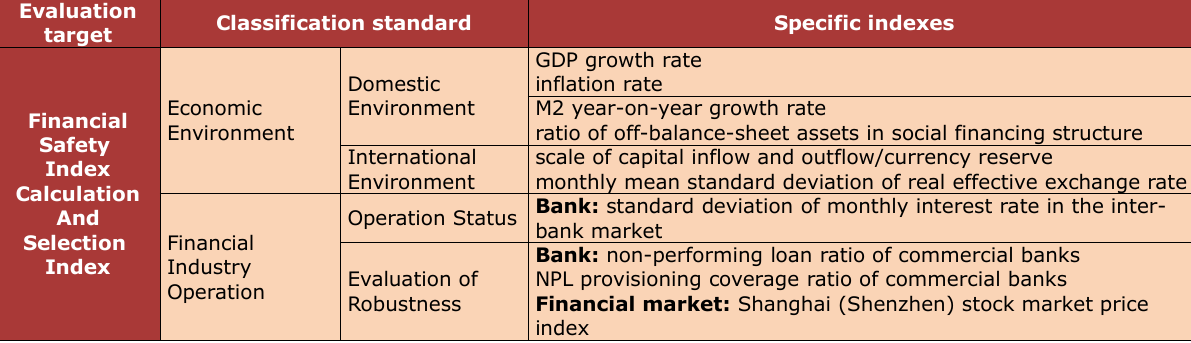
Table 1. Variables Included in the Financial Safety